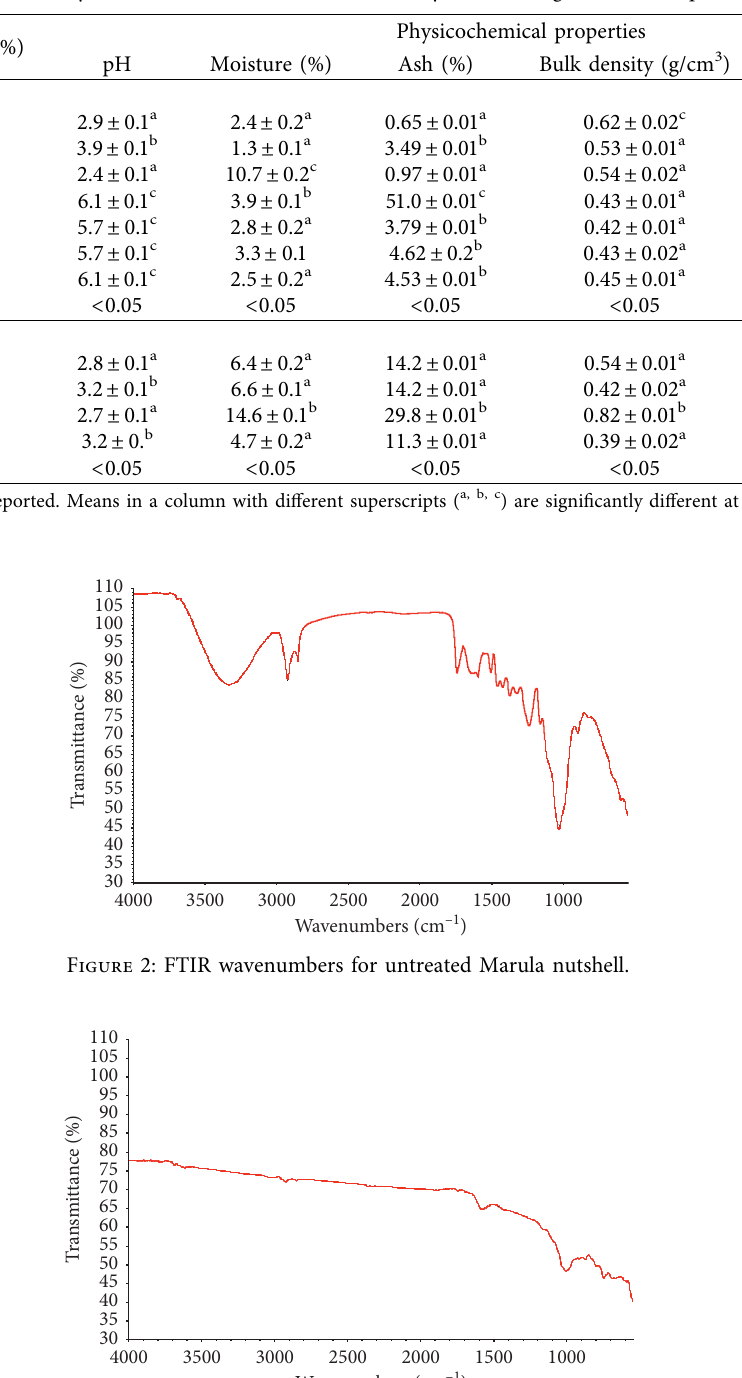
Table 5: Physicochemical characterisation of the synthesised high carbon samples.